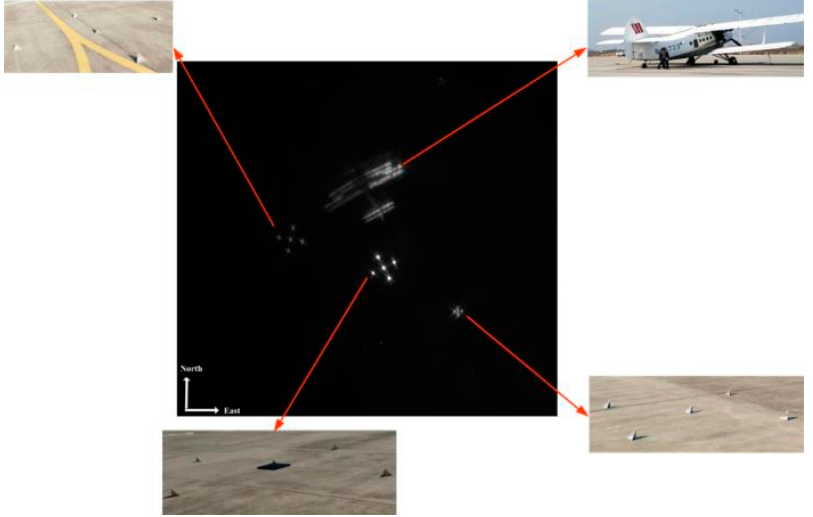
Figure 21. The image fusion result of all frames.